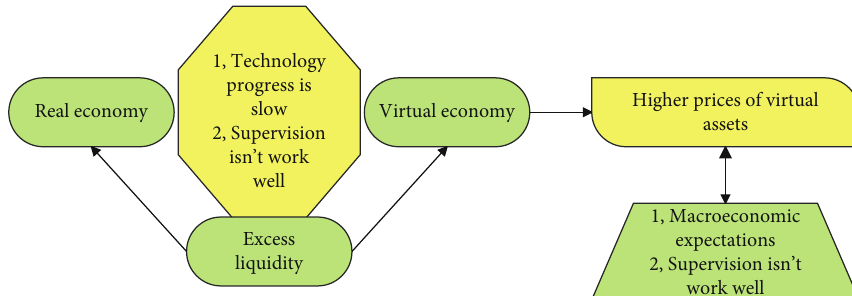
Figure 6: Formation process of the virtual economic